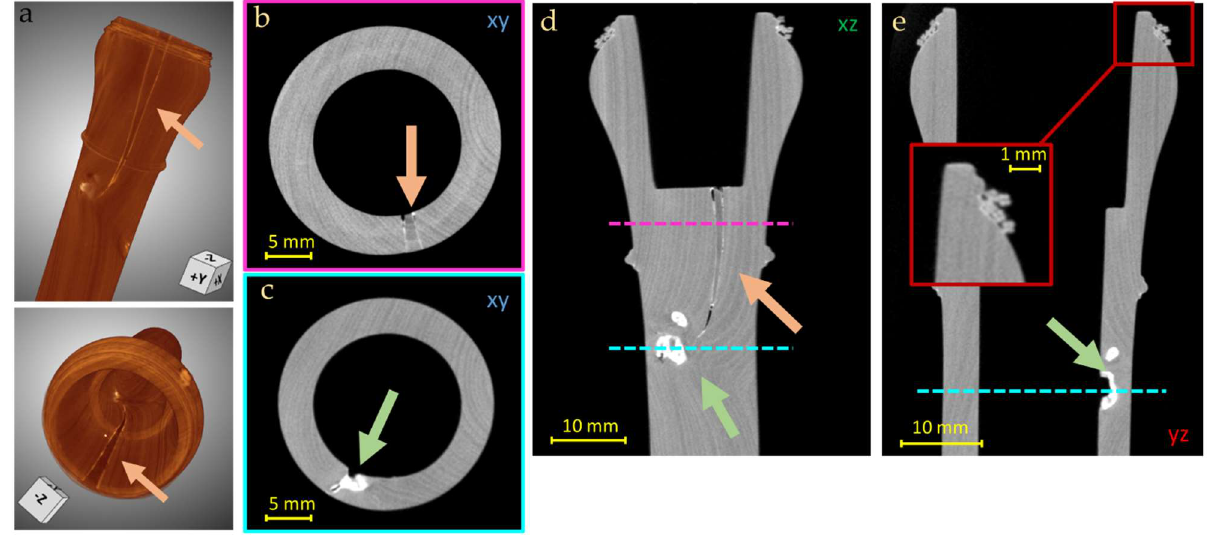
Figure 12. 3D render ( a ) and CT horizontal ( b,c ), vertical ( d ) and lateral ( e ), slices of the Transverse Flute head, where the repaired cracks are visible (orange and green arrows) and a particular of the external cord fixing ( e ). The colored lines determine the height of the two damages base on the contour of ( b,c ).